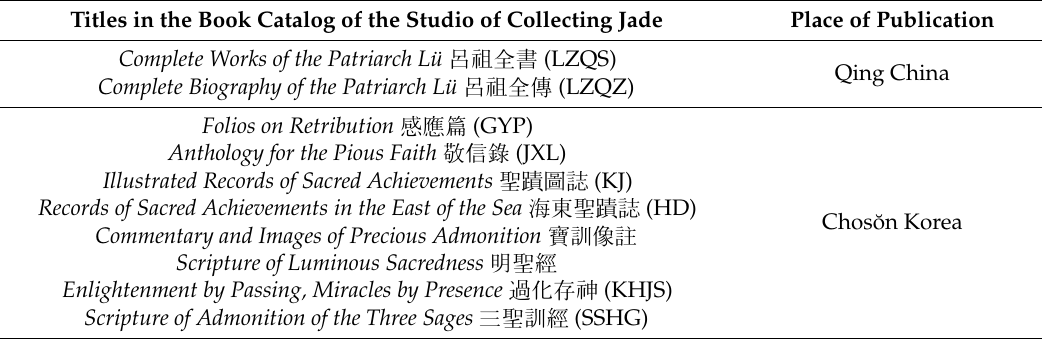
Table 1. Taoist Books and Morality Books in the Studio of Collecting